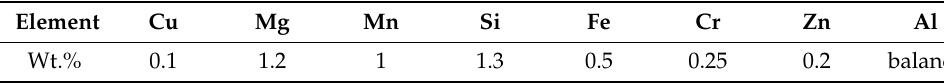
Table 2. AA6068 aluminum alloy chemical